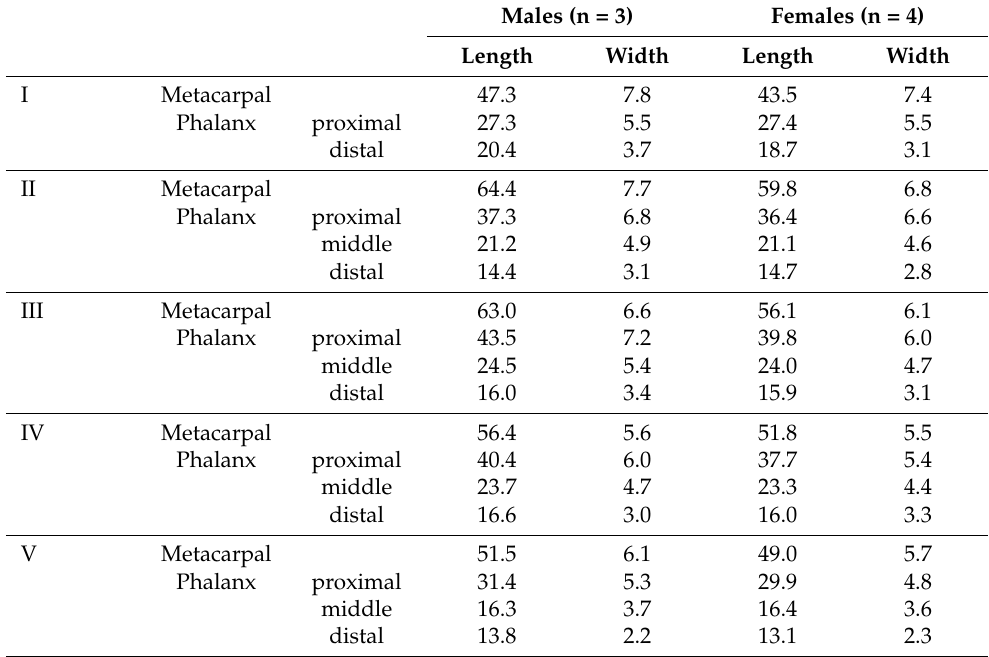
Table 4. Mean length and width of the phalangeal and metacarpal bones in adults (mm).